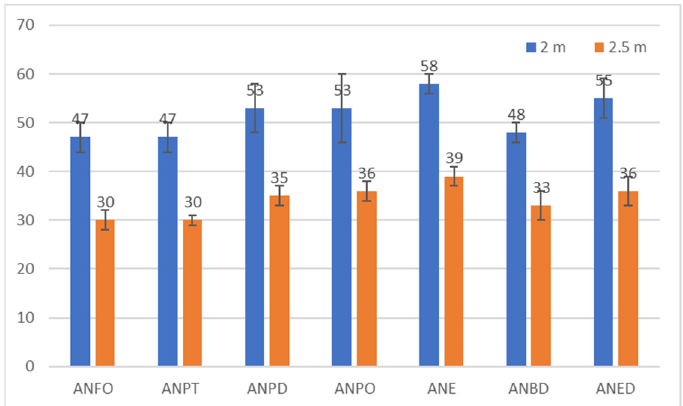
Figure 8. Dependence of maximum air blast wave overpressure on the type of organic fuel.